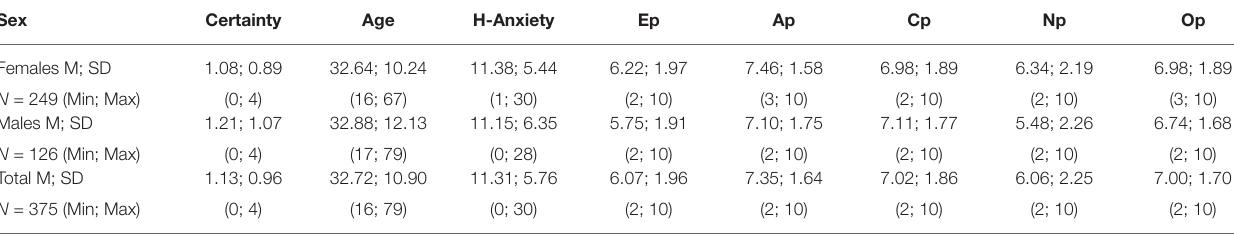
TABLE 1 | Descriptive statistics of the included variables.